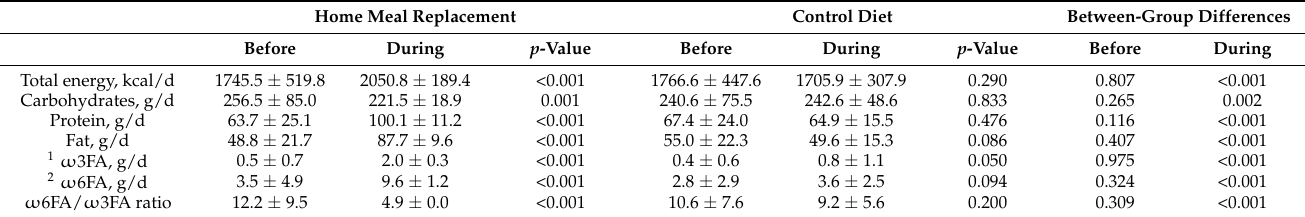
Table 2. Nutrient intake during the intervention.